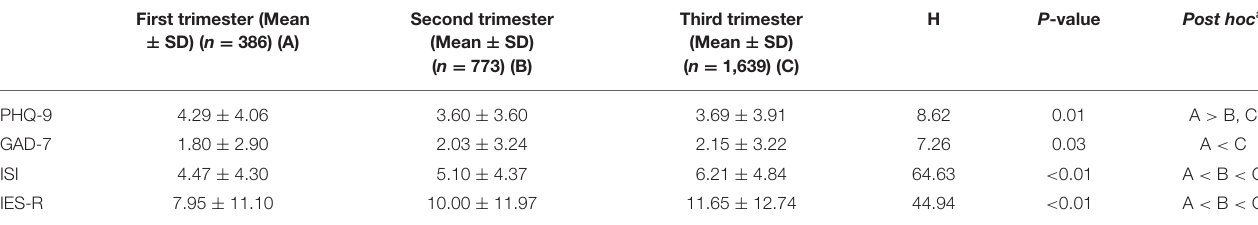
TABLE 5 | The total score of PHQ-9, GAD-7, ISI and IES-R during the COVID-19 pandemic among pregnancy trimesters. First trimester (Mean Second trimester ± SD) ( n = 386) (A) (Mean ±